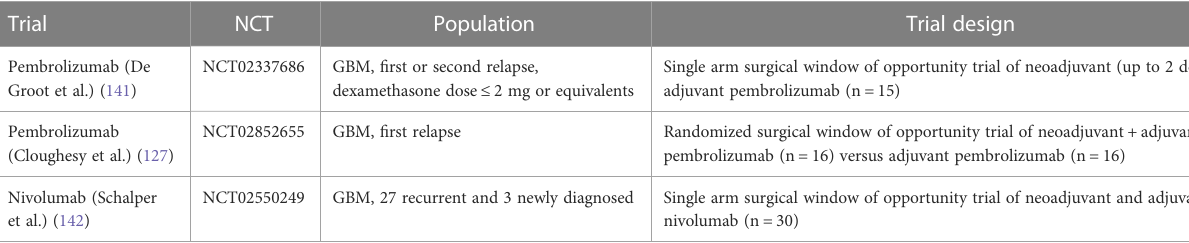
TABLE 4 Surgical Window of Opportunity Checkpoint Inhibitor Trials.